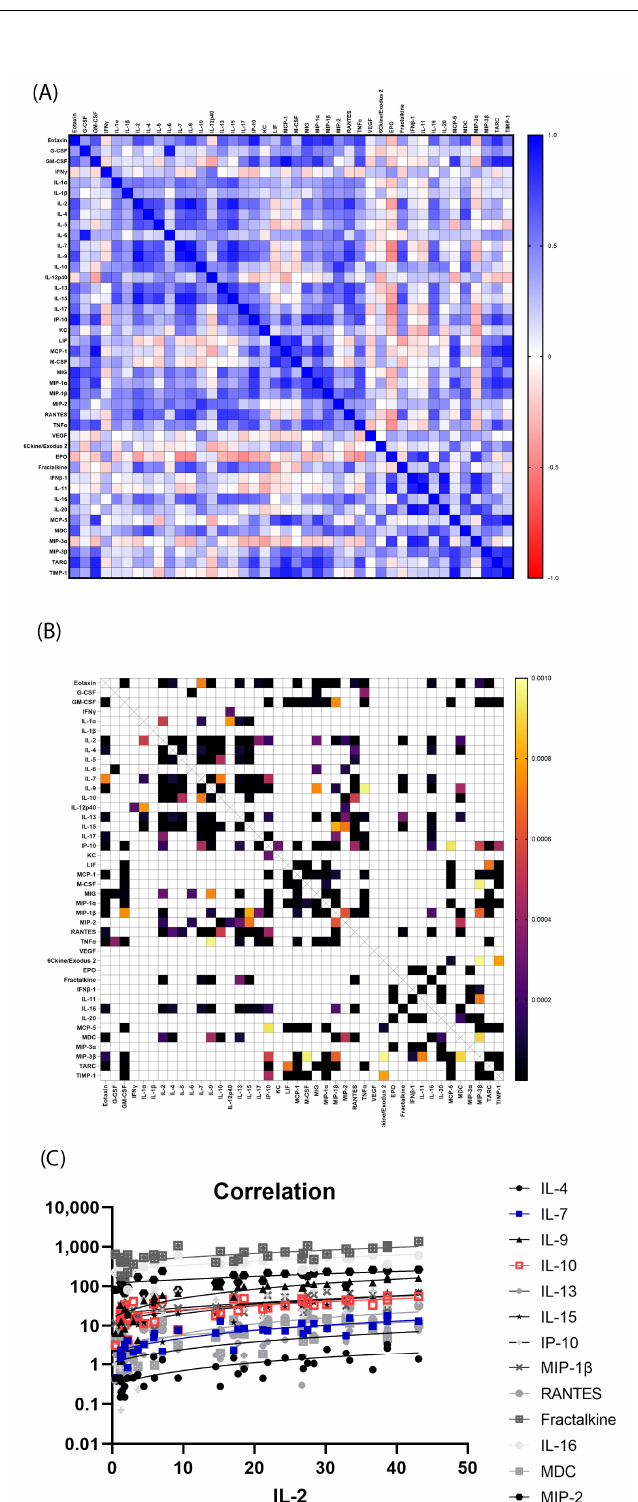
Figure 6. Correlation matrix of intestinal cytokines. All 42 intestinal cytokines were compared to each other using Pearson correlation. ( A ) Pearson r value heatmap of all intestinal cytokine combinations. Legend was shown on the right. r values closer to 1 or − 1 means positively or negatively correlated. R values closer to 0 means no correlation. ( B ) p value heatmap of all intestinal cytokine combinations. Legend was shown on the right. Only p values < 0.001 were shown to simplify the view. ( C ) Intestinal cytokines that were significantly correlated with intestinal IL-2. All their p values were smaller than 0.001. All cytokines’ concentration unit was